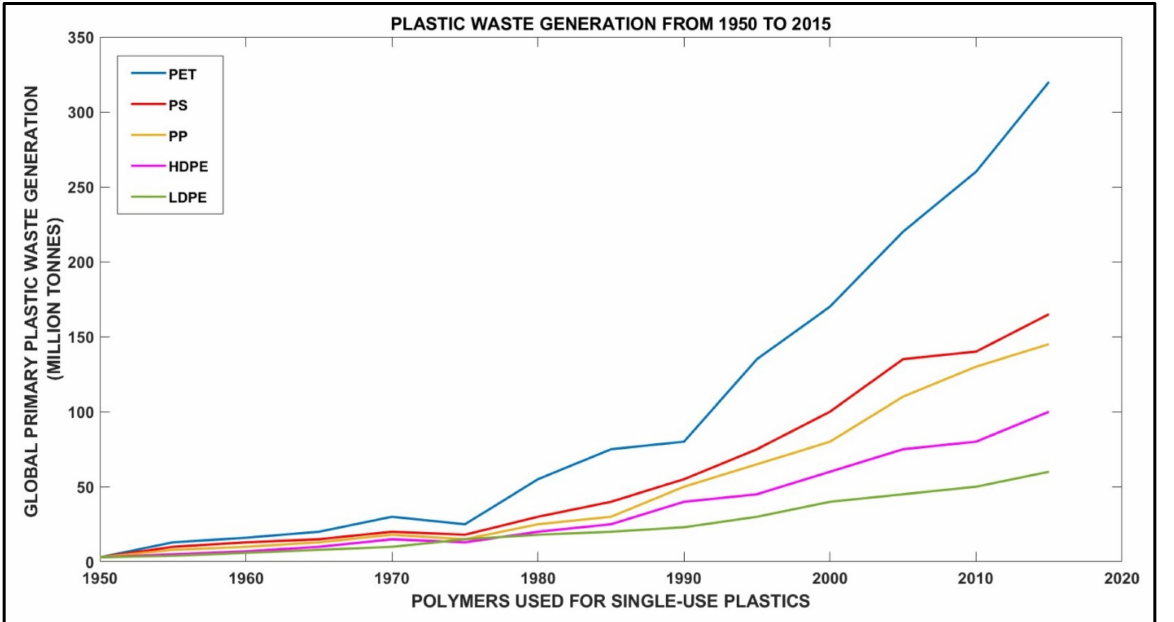
Figure 4. Global primary plastic waste generation, 1950–2015 (Adapted with permission from Refer- ence [66]. 16 July 2022, Ibrahim Almeshal, Bassam A Tayeh, Rayed Alyousef, Hisham Alabduljabbar, Abdeliazim Mustafa Mohamed, Abdulaziz